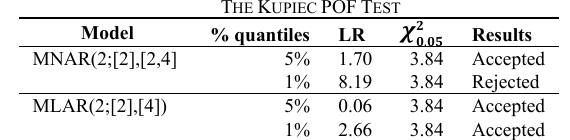
TABLE 5 T HE K UPIEC POF T